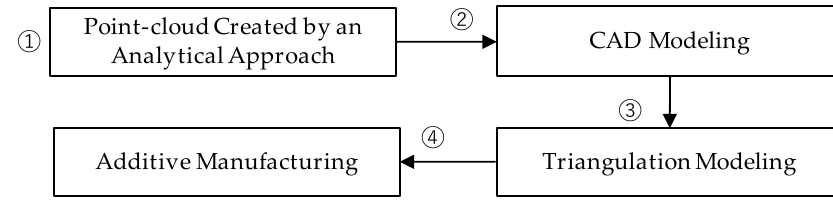
Figure 3. Proposed method for Point-Cloud based Additive Manufacturing (PCAM).